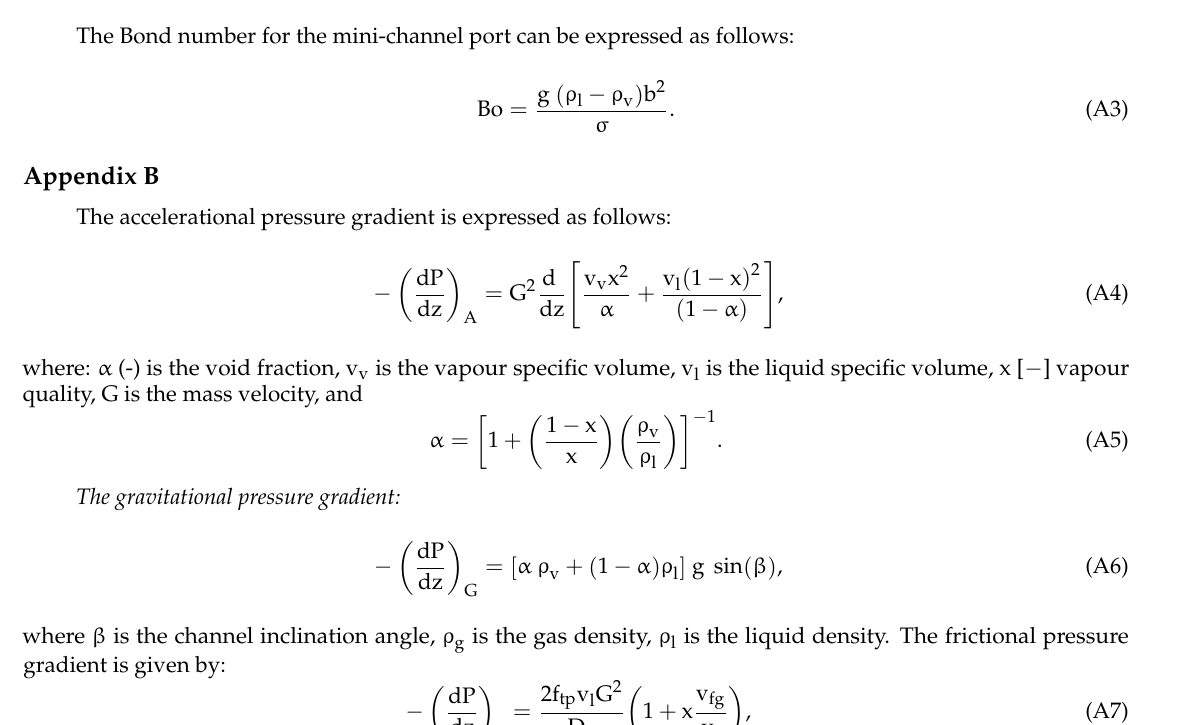
β and the Bond number 3 with the inclination angle